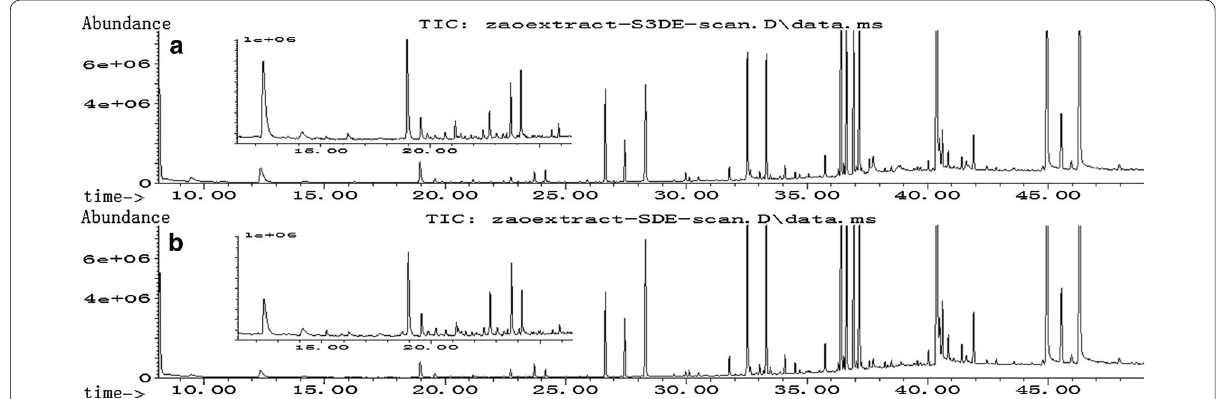
Fig. 2 The GC/MS chromatogram of volatile components in jujube extract. The samples of a and b were prepared by S3DE and SDE, respectively